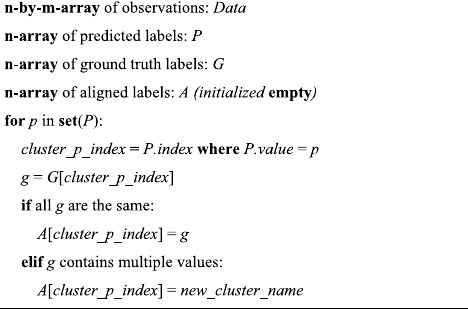
Algorithm 1. Align cluster labels with matching ground truth labels.